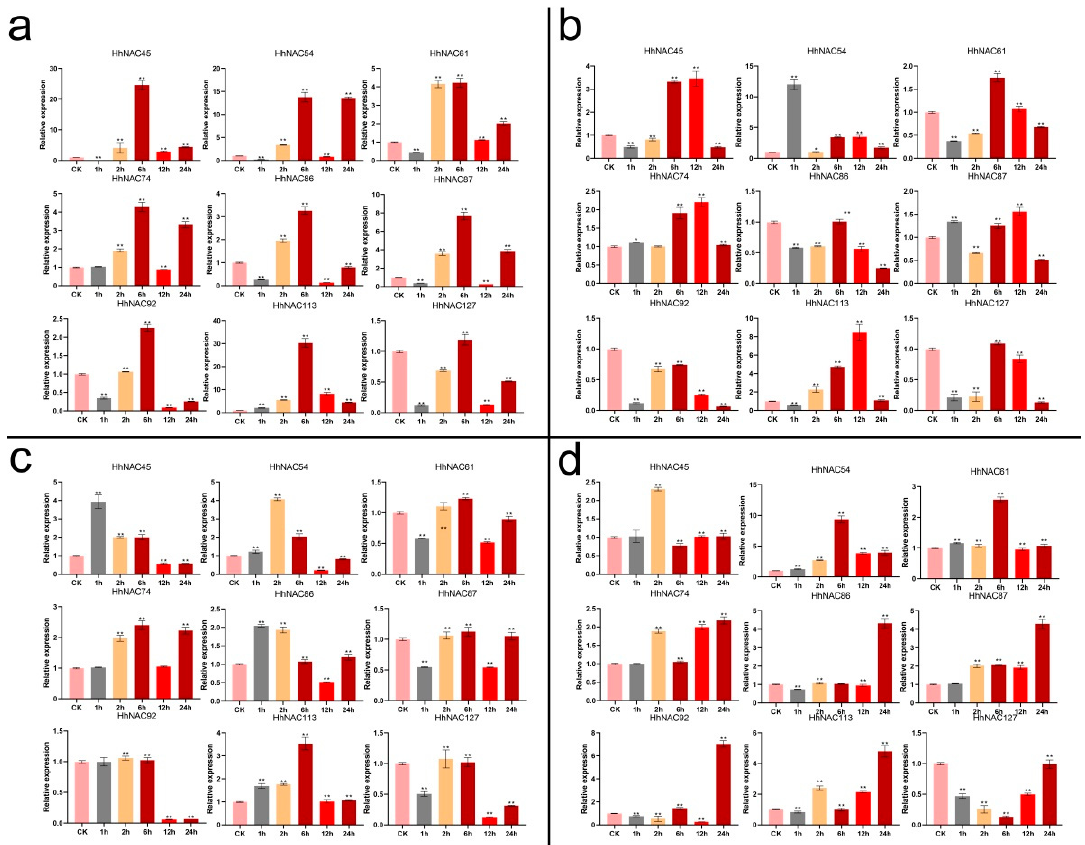
Figure 6. HhNAC genes were analyzed by qRT-PCR. The significance analysis was carried out using Student’s t -test (* p < 0.05, ** p < 0.01).